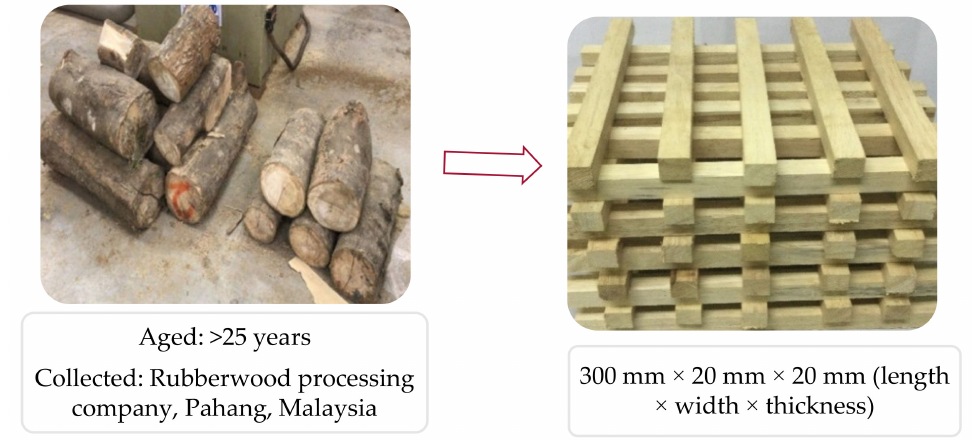
Figure 1. Photograph of prepared rubberwood samples with dimensions of 300 mm × 20 mm × 20 mm (length × width × thickness) for hydrothermal